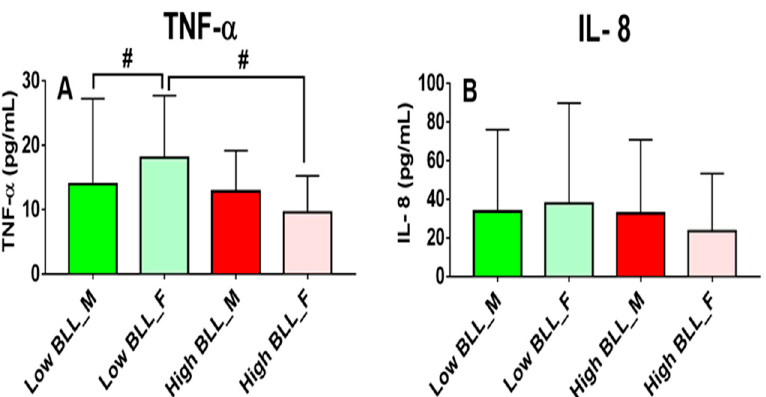
Figure 1. Cytokines in adult female and male plasma samples across the two groups. Key: Low BLL_M = low BLL group in males; Low BLL_F = low BLL group in females; High BLL_M = high BLL group in males; High BLL_F = high BLL group in females (mean ± SD). ( A ) Tumor necrosis alpha (TNF- α ) and ( B ) interleukin-8 (IL-8). (# represents p < 0.05, Mann–Whitney test).